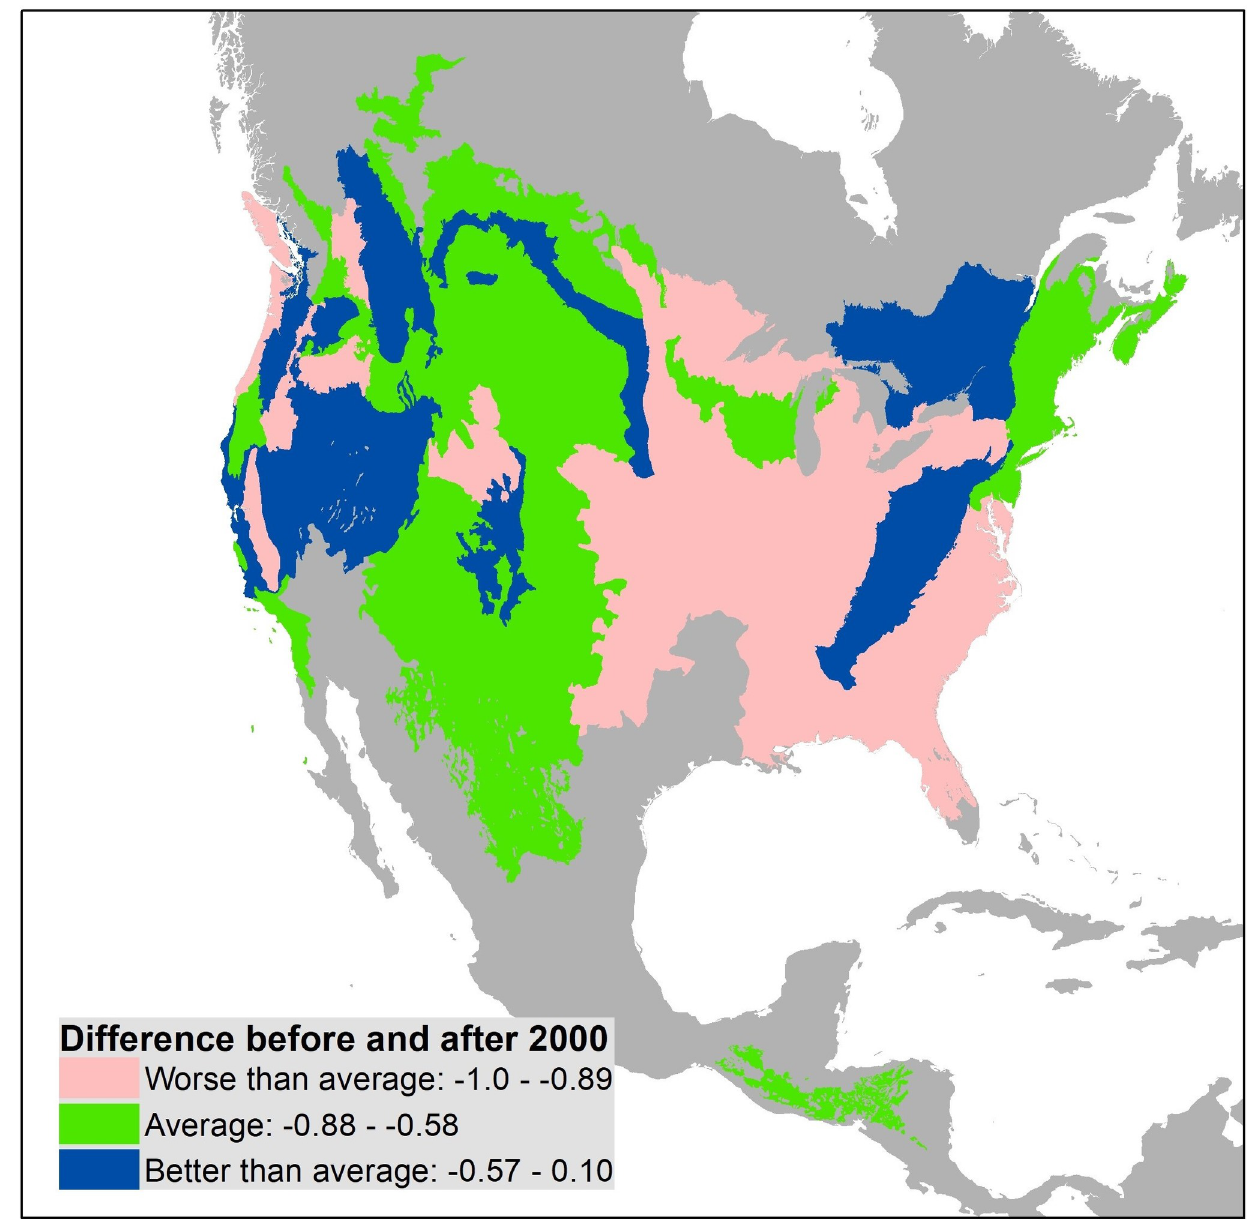
Fig 6. Change in the detection of M . frenata from museum and iNaturalist records between 1960–1999 (n = 736 records) and 2000–2020 (n = 843 records). For each era, detections are standardized as a proportion of all M . frenata records from a given ecoregion, with colors coded to highlight those doing worse than average (pink), within 15% points of average (green), and better than average (blue) as in Table